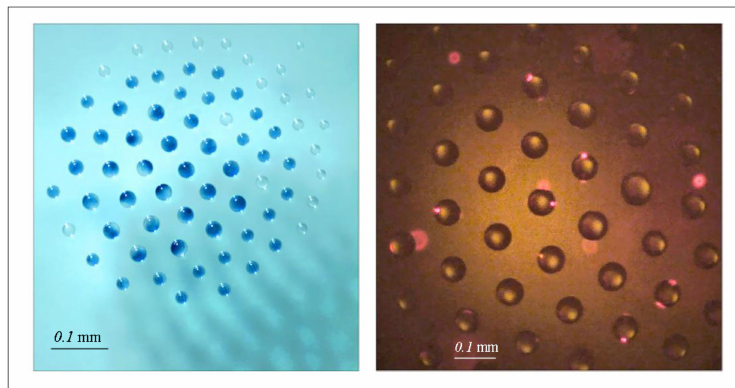
Figure 7. Photographs taken during bioaerosol experiments with the droplet